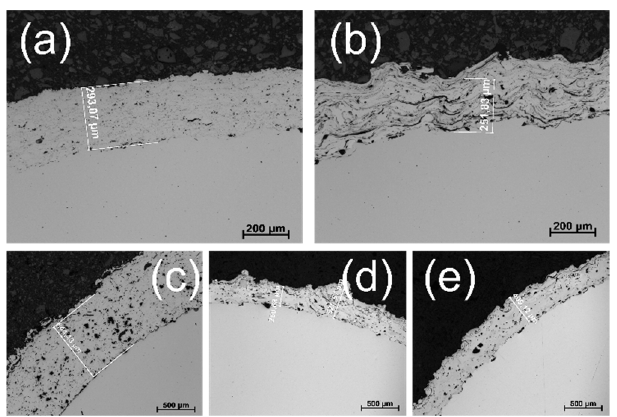
Figure 2. Optical light micrographs of the thermally sprayed coatings before testing: ( a ) HVOF Amperit 469, ( b ) TWAS 45CT, ( c ) Plasma K50, ( d ) TWAS Alloy 625, and ( e ) TWAS pseudo-alloy.